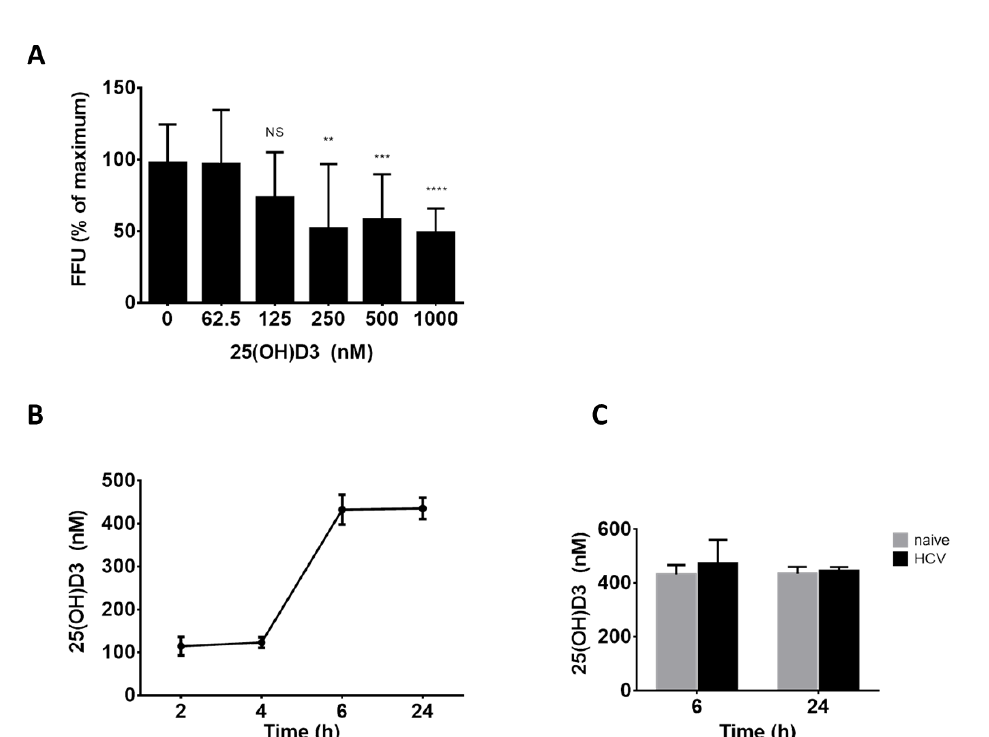
Figure 2. Involvement of 25(OH)D 3 in mediating vitamin D 3 anti-HCV e ff ect. ( A ) Inhibition of HCV HJ3-5 virus production as determined by FFU assay of virus released into media following infection and treatment with 25(OH)D 3 (62.5–1000 nM). Percent of FFU was calculated by comparing with virus released in nontreated cell cultures (0). Mean values ± SD of three di ff erent experiments are presented. Statistical significance was calculated by two-tailed Student’s t test and is indicated as follows: ** p < 0.05, *** p < 0.01, **** p < 0.0001; ns—nonsignificant. ( B ) ELISA analysis of 25(OH)D 3 levels produced by noninfected Huh7.5 cells 2–24 h post-treatment with vitamin D (5 µ M) and ( C ) HCV infected and noninfected cells 6 and 24 h post-treatment with vitamin D (5 µ M). A representative experiment out of two was performed in triplicates.